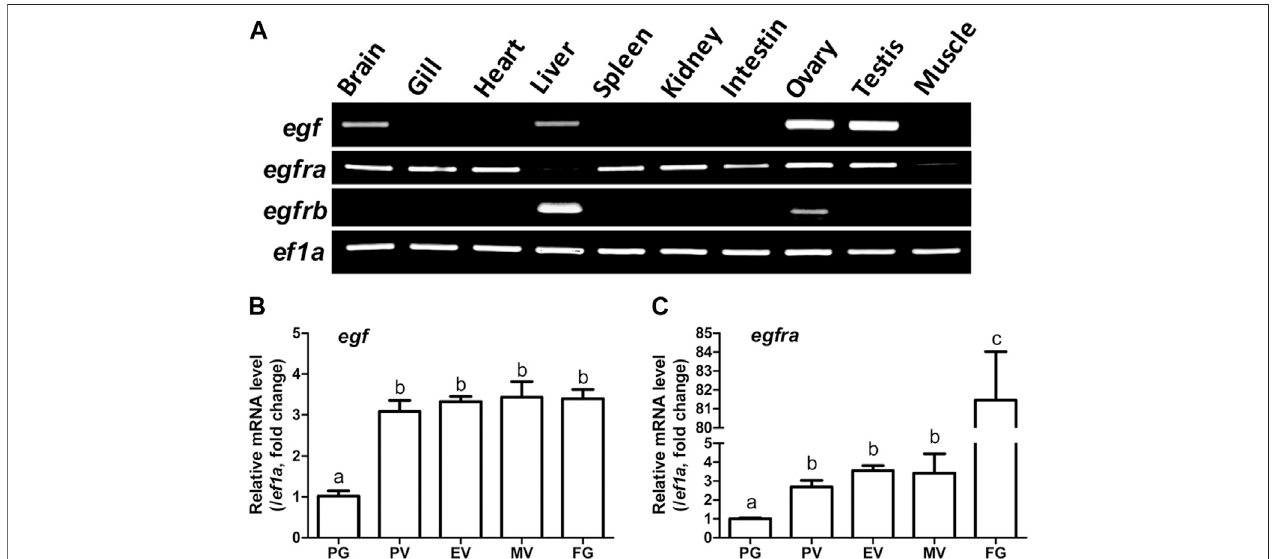
FIGURE 1 | Tissue distribution of egf , egfra, and egfrb, and temporal expression pro fi les of egf and egfra during folliculogenesis. (A) RT-PCR analysis showed that egf wasmainlyexpressedintheovaryandtestiswithweakexpressioninthebrain,liver,andgill,whereas egfra wasexpressedinallorgans,butwithlowlevelsintheliver andmuscle.Incontrast, egfrb wasexclusivelyexpressedintheliverandovarywithhigherlevelintheliver. (B,C) Theexpressionof egf and egfra mRNAwaslowinthePG folliclesandincreasedsigni fi cantlyinthePVfollicles.ThemRNAlevelof egf maintainedrelativelyconstantafterPVstage,whereastheexpressionof egfra showeda secondsurgeinFGfolliclespriortomaturation. Theexpression levelsoftargetgeneswerenormalizedtothatofhousekeepinggene ef1a ,andexpressed asfoldchange compared with that in PG follicles. Different letters indicate statistical signi fi cance ( n (cid:1) 3). PG, primary growth; PV, previtellogenic; EV, early vitellogenic; MV, mid- vitellogenic; FG, full-grown. EGF/ egf , epidermal growth factor; EGFR/ egfr , epidermal growth factor